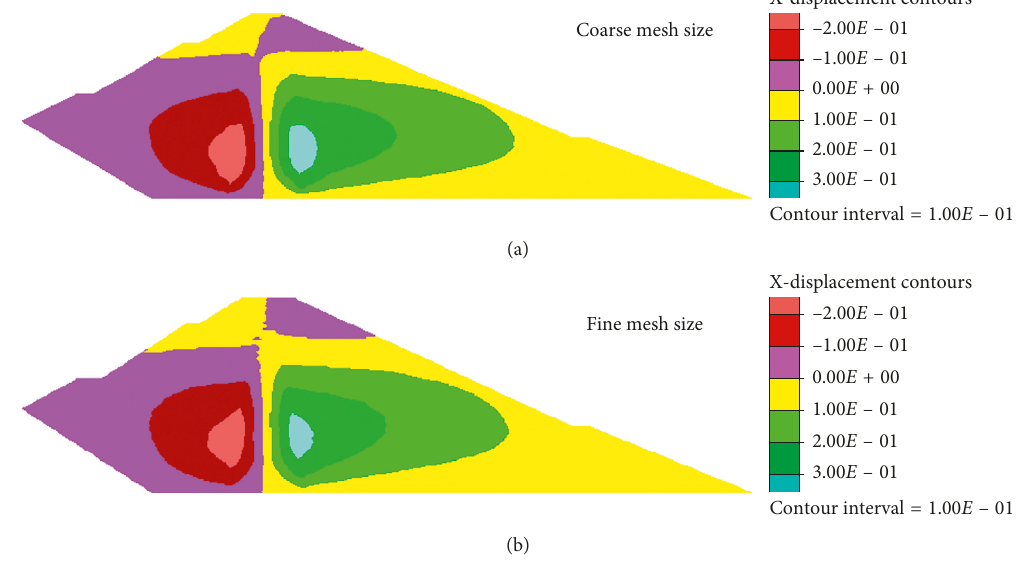
Figure 5: Vertical displacement of samples one and two. (a) Coarse mesh size. (b) Fine mesh